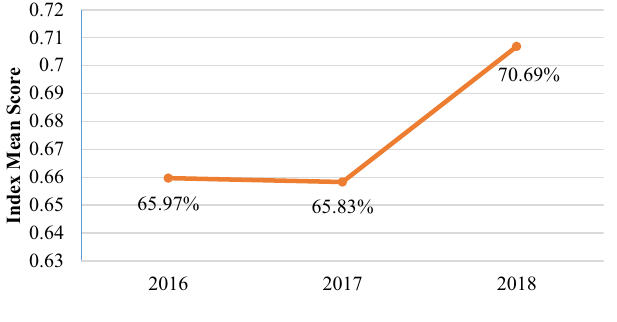
Figure 1. Integrated